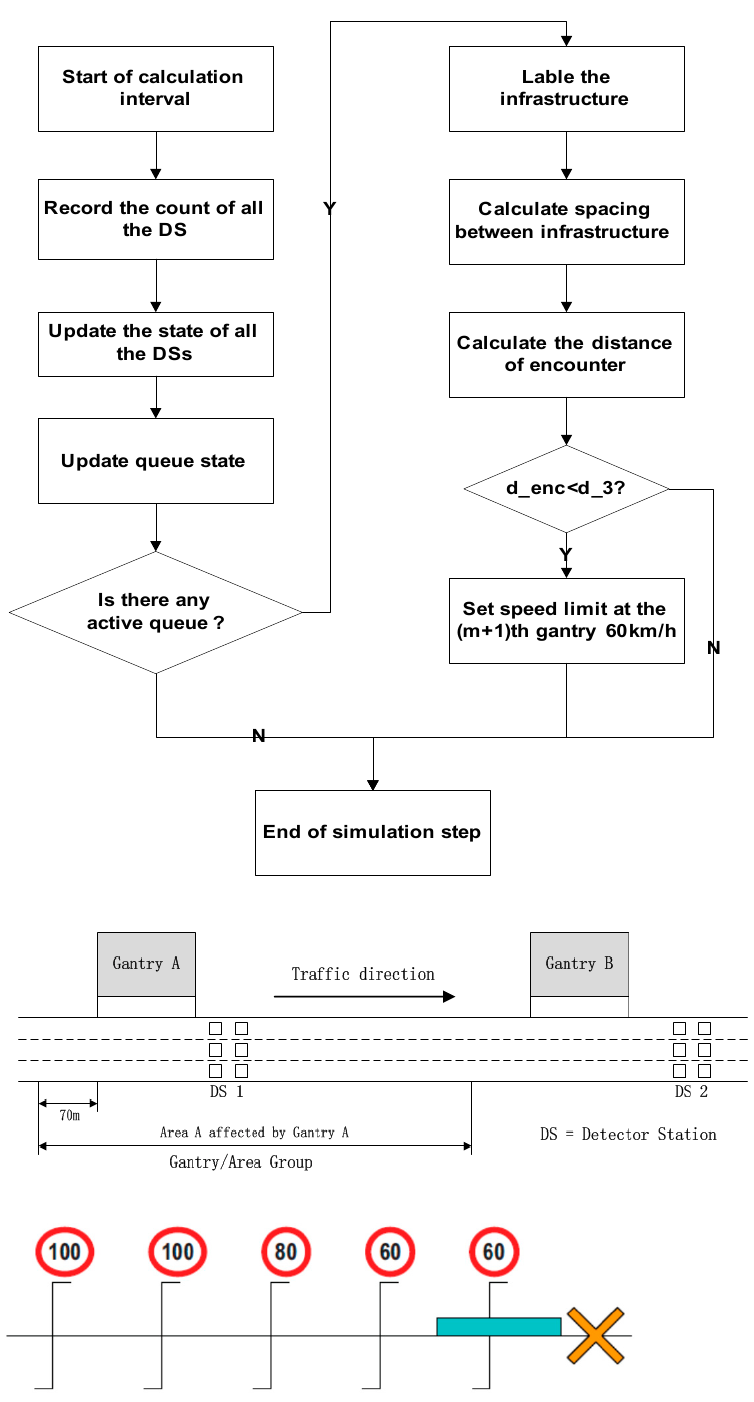
Figure 9. Schematic Queue Protection algorithm and a demonstration of the speed limit changes at the time of queue detection by the algorithm [16,50].